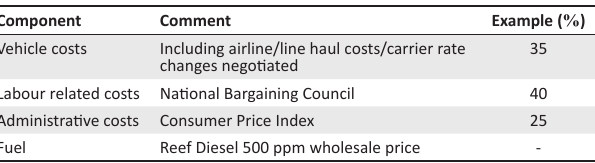
FIGURE 2: Trend in the price of diesel, and